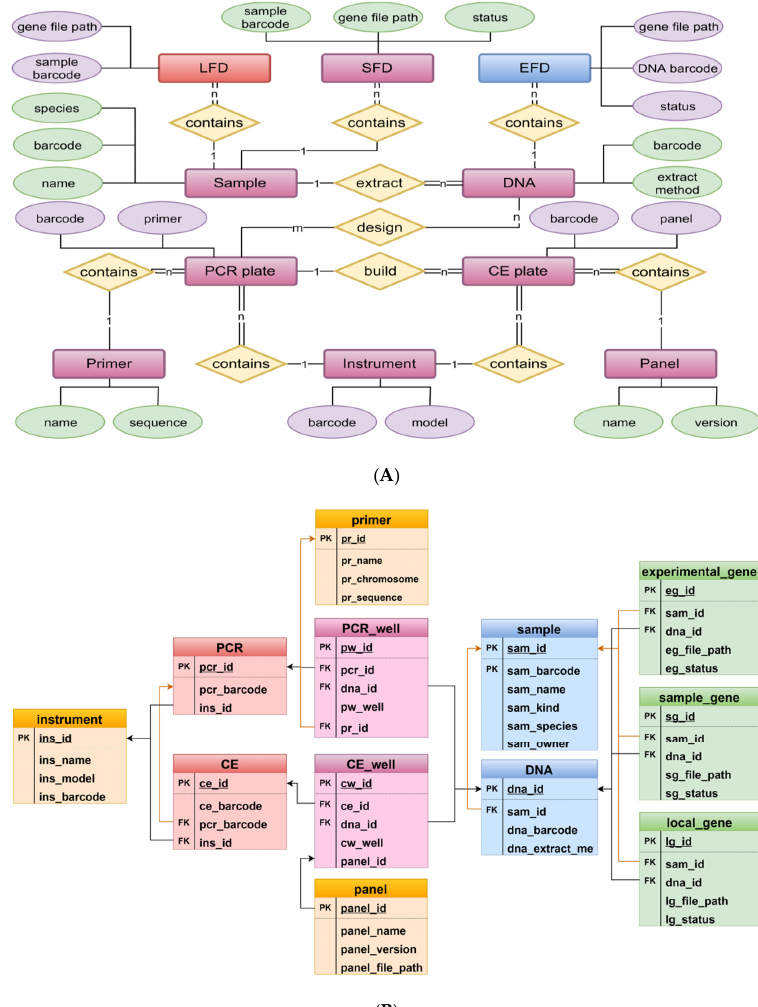
Figure 3. Entity relationship and class table models in PIDS. ( A ) Entity relationship model diagram (ERD) based on Chen’s ERD notation. The rectangular boxes indicate entities; ellipses indicate properties of the entities; and diamonds indicate relationships between entities. LFD, Local Fingerprint Database; SFD, Sample Fingerprint Database; EFD, Experimental Fingerprint Database. ( B ) Table-like model diagram based on the ERD. The top of each box contains the table name. Primary key (PK) indicates a primary key. Foreign key (FK) indicates a foreign key to another table and is indicated by an arrow.